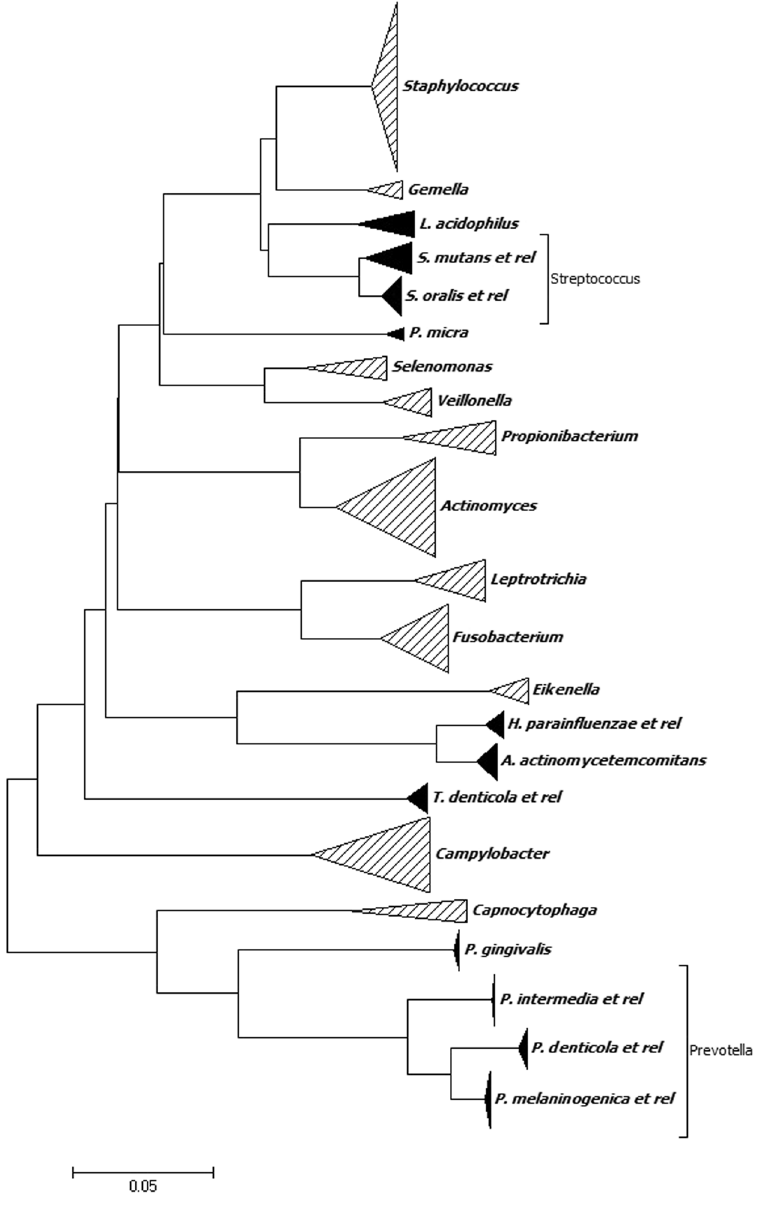
Figure 1. Phylogenetic tree of the oral microrganisms targeted by the OralArray. The tree was obtained from the entire positive set used for the probe design. The neighbor-joining method was used to infer evolutionary history. The evolutionary distances were computed using the maximum composite likelihood method and units correspond to the number of base substitutions per site. The analysis involved 383 nucleotide sequences (Supplementary Table S2). All positions containing gaps and missing data were eliminated. Evolutionary analyses were conducted by using MEGA6